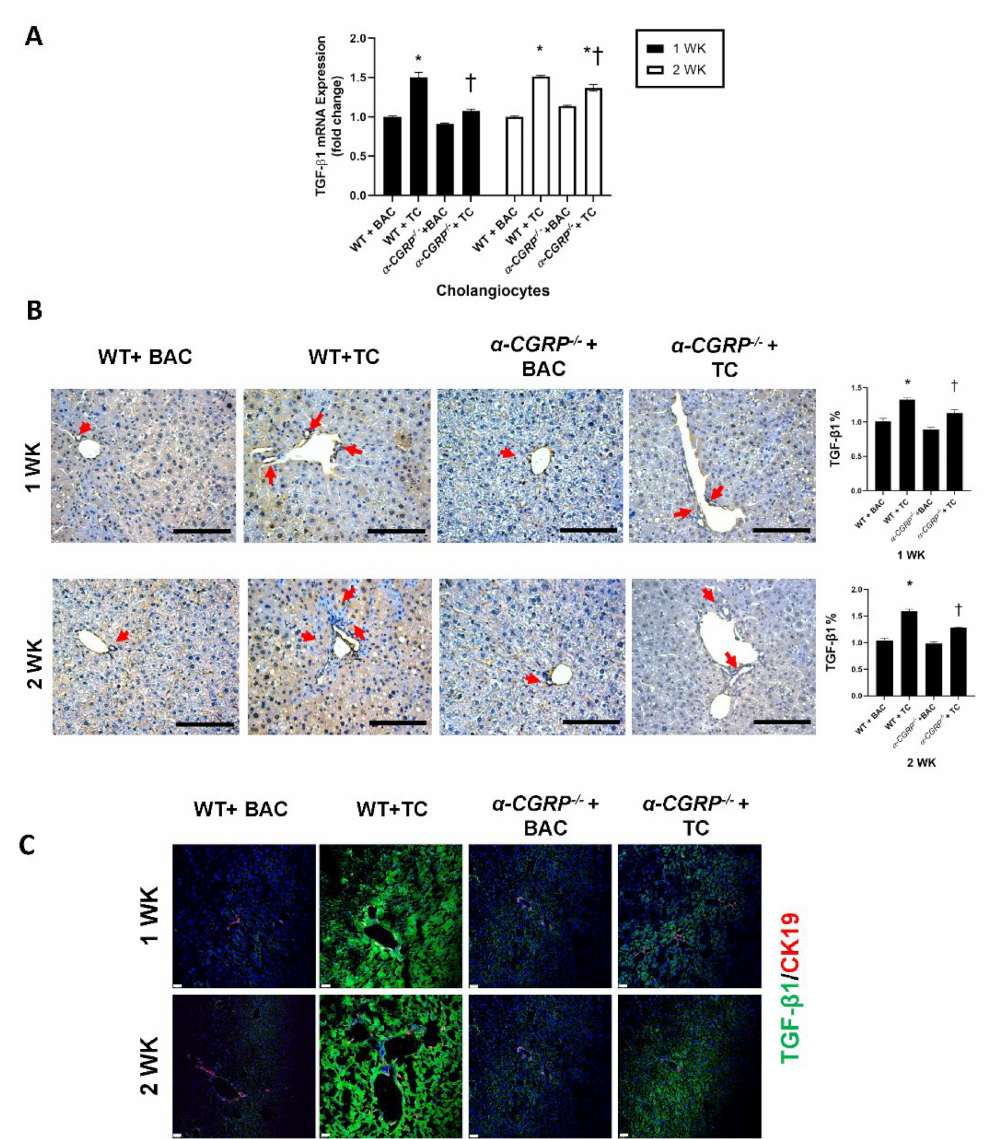
Figure 8. α -CGRP − / − mice fed with TC have decreased expression of TGF- β 1 in liver. ( A ) q PCR in isolated cholangiocytes as well as ( B ) immunohistochemistry of WT mice fed TC have increased biliary TGF- β 1, which is significantly reduced in α -CGRP − / − mice fed with TC compared to WT fed BAC. Original magnification 20 × . Scale Bar 100 µ m. Data are mean ± SEM of scanning slides from n = 3 different animals per groups. This phenotype was confirmed by ( C ) immunofluorescence staining of TGF- β 1 co-staining with CK19. Data from q PCR are mean ± SEM of three evaluations from three cumulative preparations of cholangiocytes from five mice per group. Original magnification 20 × . Scale Bar 20 µ m.* < p value vs. WT + BAC. † < p value vs. WT +